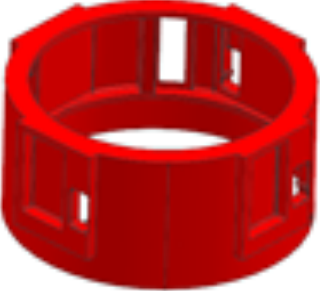
Figure 10. The three-dimensional structure of cabin parts.